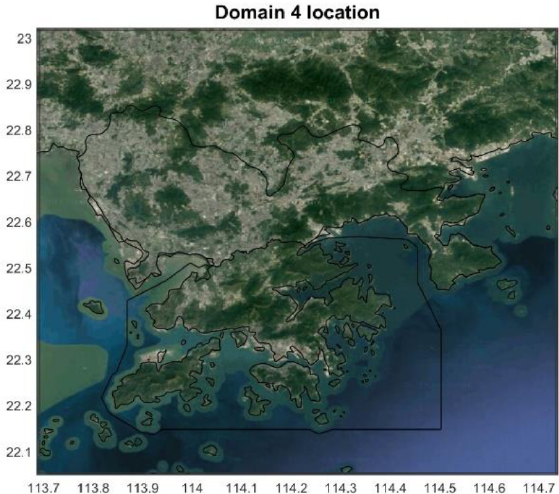
Figure 1. The study area was delineated in the modeling as the in- nermost domain (domain 4). Base map source: © Google